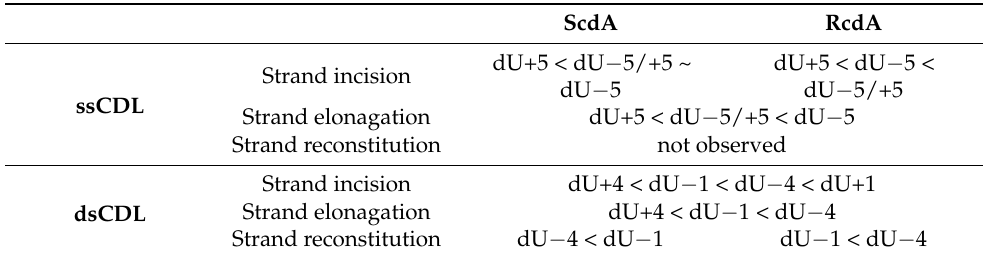
Table 2. The observed trends of the main stages of nuclear BER in XPC cell line for single-stranded (ssCDL) and double-stranded (dsCDL) clustered DNA lesions containing AP site and 5 (cid:48) S or 5 (cid:48) R isomer of 5 (cid:48) ,8-cyclo-2 (cid:48) -deoxyadenosine (ScdA or RcdA). Substrate annotations and oligonucleotide sequences are presented in Table